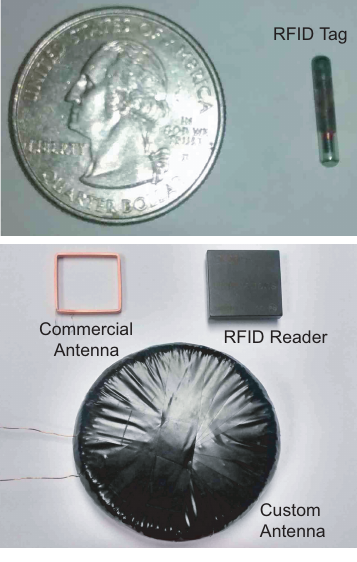
Figure 6. PIT tag ( top ) RFID reader, and reader antennas; ( bottom ) in the proposed smart feeder